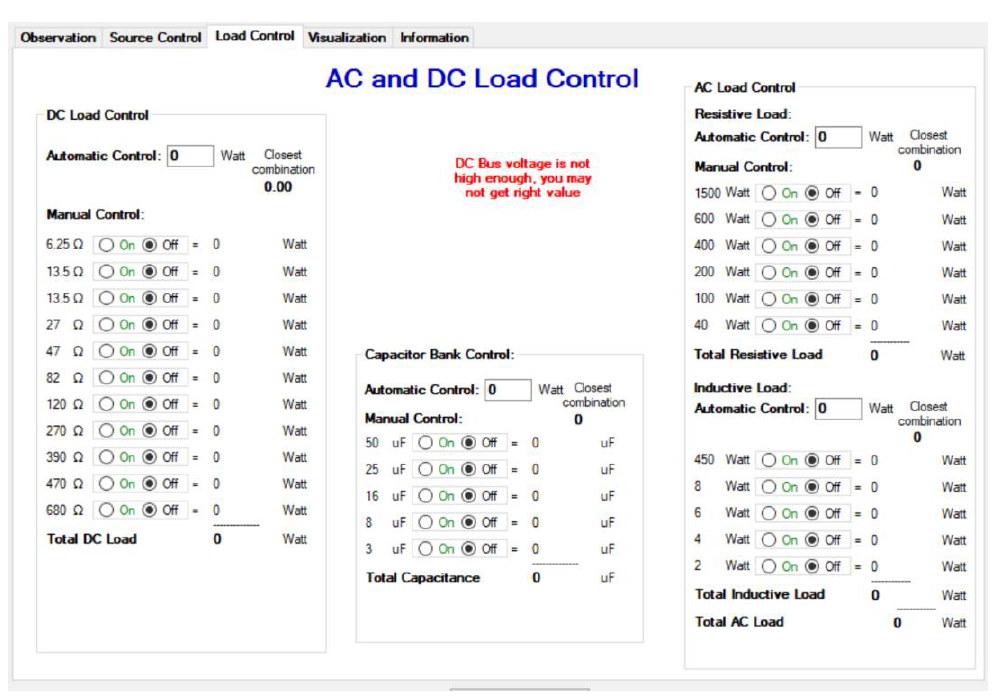
Figure 11. Microcontroller control user interface.